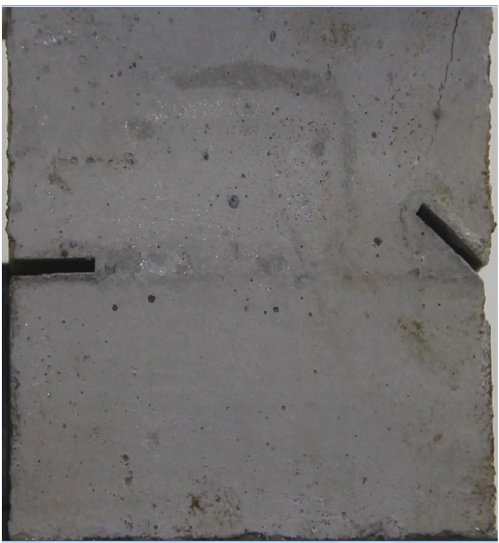
Figure 57. Photograph of a specimen showing tensile crack from the top surface caused by compression appearing.